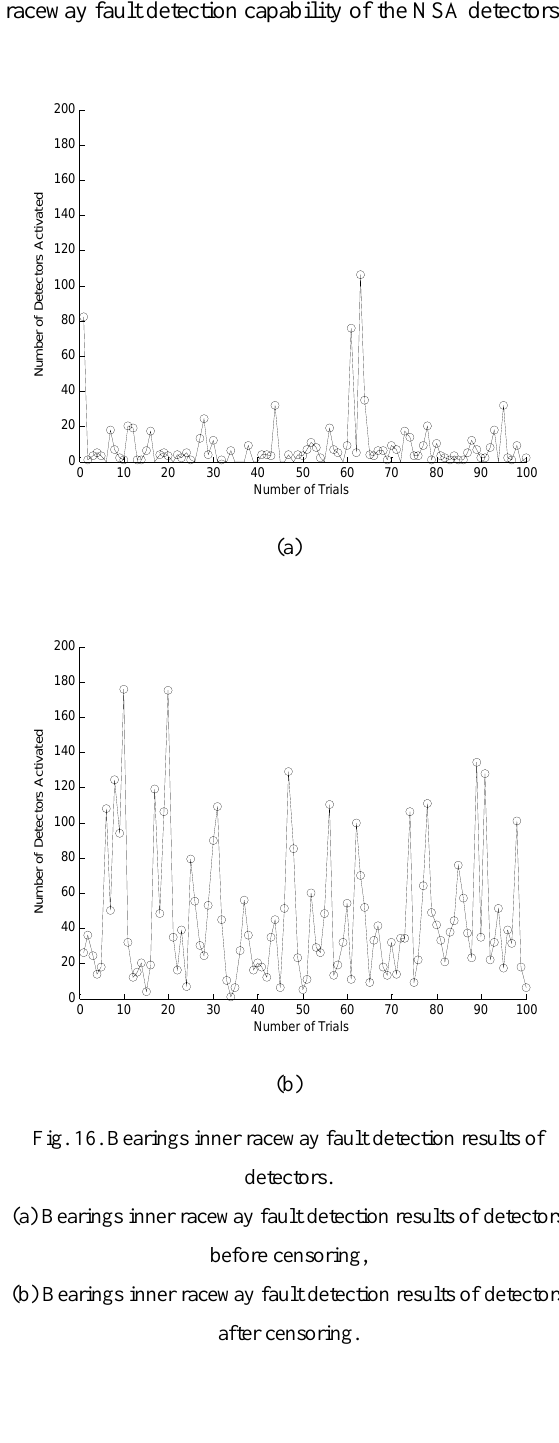
Table 4. Bearings inner raceway fault detection